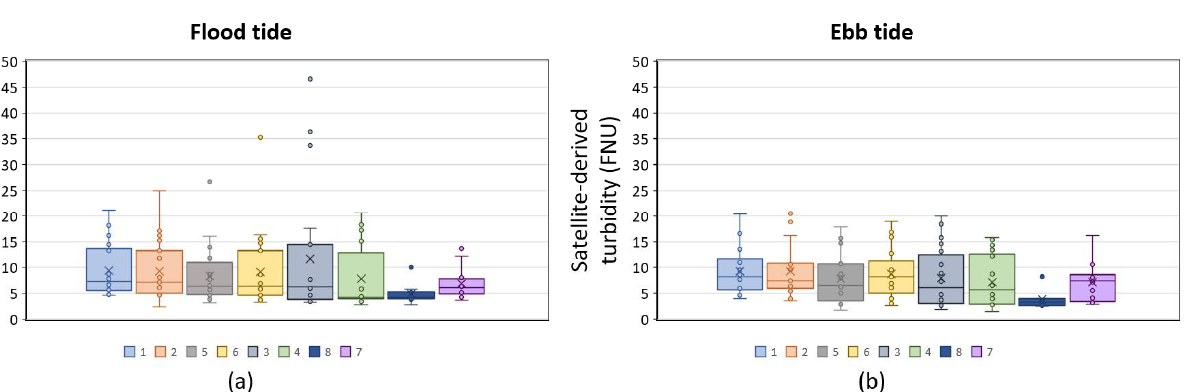
Figure 4. Box-plots of the satellite-derived turbidity in ( a ) flood and ( b ) ebb-tide phases for the 8 sampling stations in Figure 1. Stations are ordered following the lagoon–sea transect for SN channel, excluding Station 7, which is located in the TRP channel. The × mark indicates the mean value, the box represents the interquartile range, the line in the box is the median and the whiskers represent the tails of the distribution with external solid points representing the